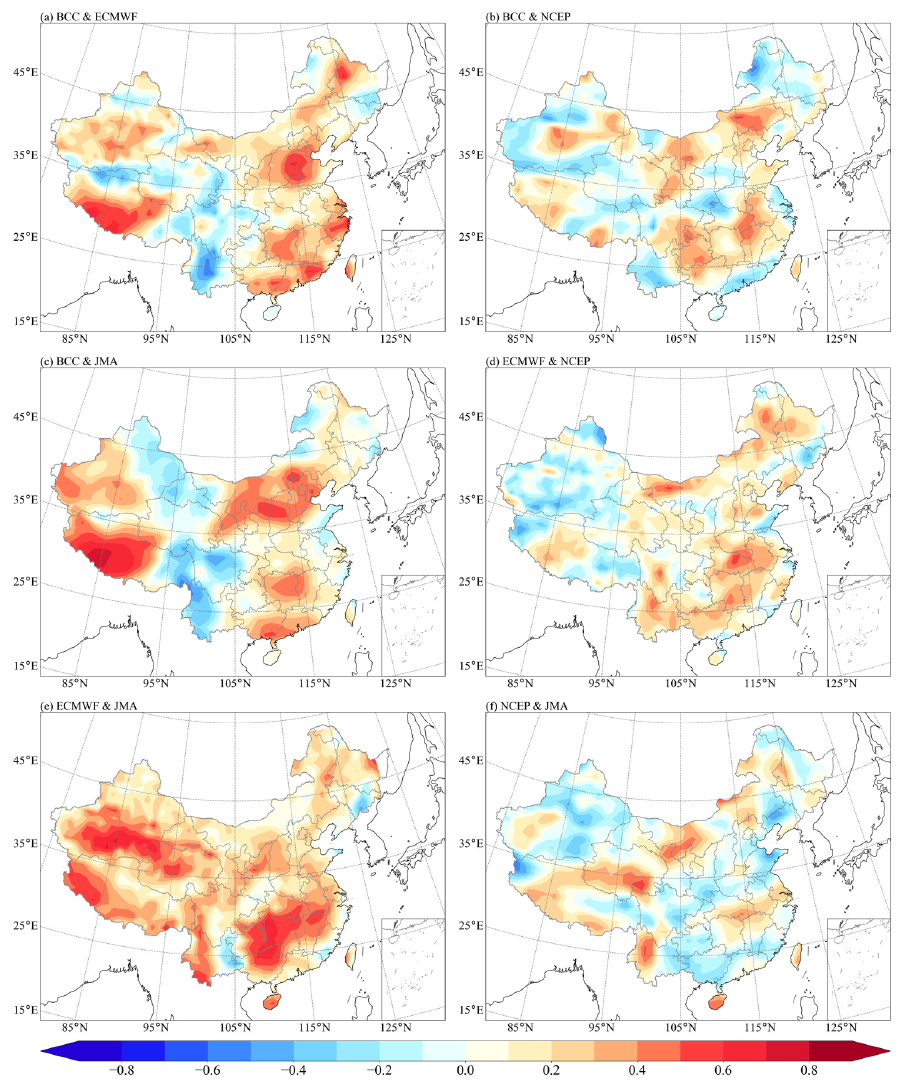
Figure 4. The time correlation coefficients between the different model prediction: ( a ) TCC between BCC and ECMWF, ( b ) TCC between BCC and NCEP, ( c ) TCC between BCC and JMA, ( d ) TCC between ECMWF and NCEP, ( e ) TCC between ECMWF and JMA, and ( f ) TCC between NCEP and JMA.